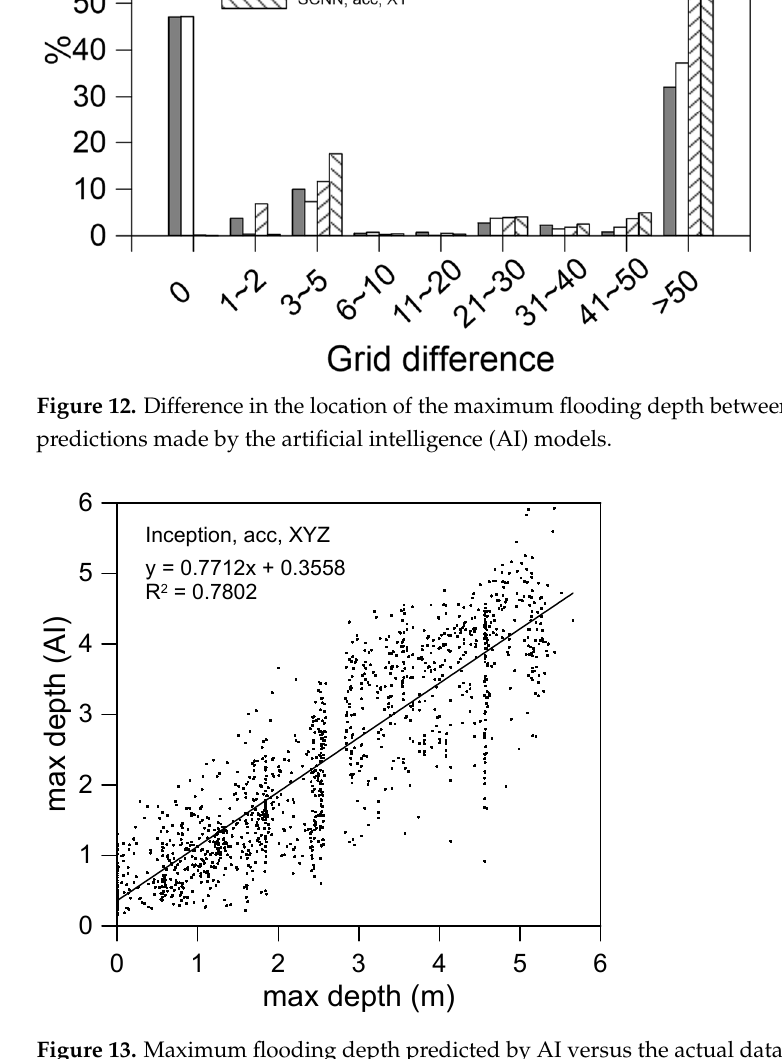
Figure 12. Difference in the location of the maximum flooding depth between the actual data and the predictions made by the artificial intelligence (AI) models.